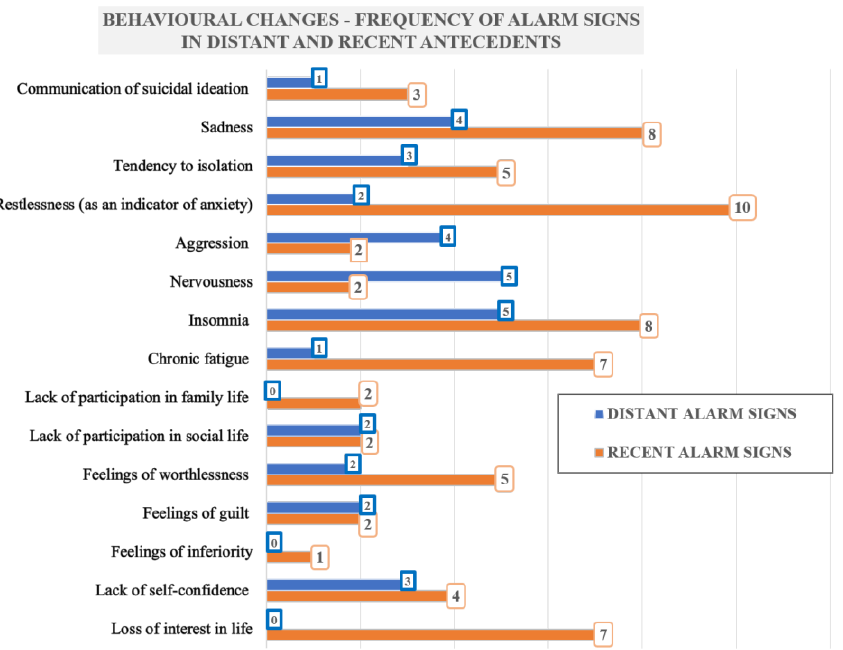
Figure 1. Variation of behavioral changes in the distant and recent antecedents.